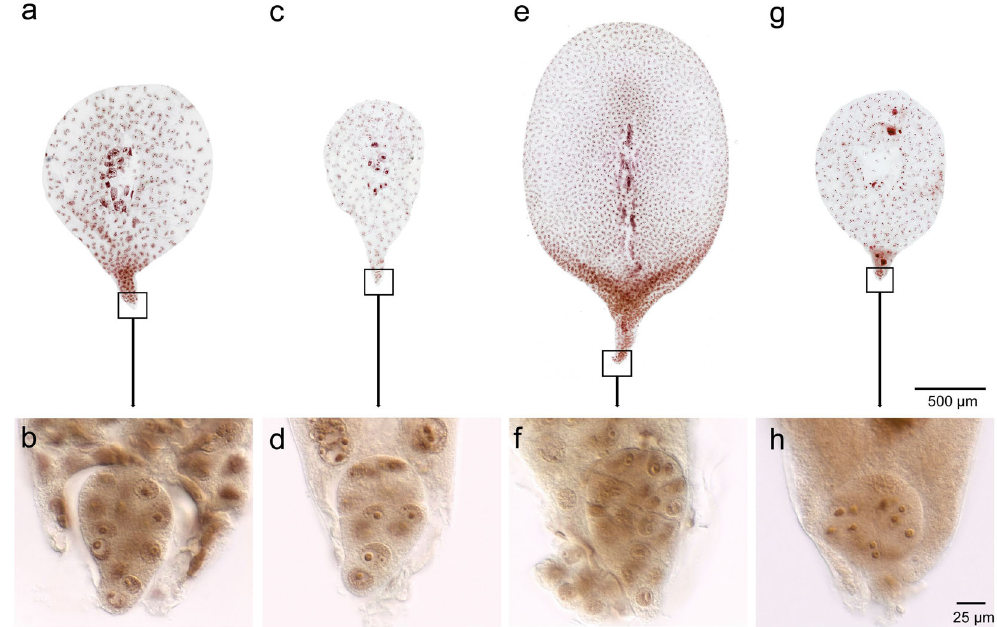
Fig. 2 Embryo and endosperm development of wheat x rye crosses. a , b CS x L6, 3 DAP. c , d CS N1D/T1A x L6, 3 DAP. e , f CS x L6, 5 DAP. g , h CS N1D/ T1A x L6, 5 DAP, isolated embryo sacs. While between 3 DAP and 5 DAP the embryo sac of CS x L6 signi fi cantly increases ( a , e ), that of N1D/T1A x L6 hardly increased size ( c , g ). Detail recordings of the embryo show that at 3 DAP embryos of both crosses appeared similar ( b , d ). At 5 DAP the embryo of CS x L6 grew in size ( f ) while that of N1D/T1A did not grown and showed clear signs of nuclear degradation.